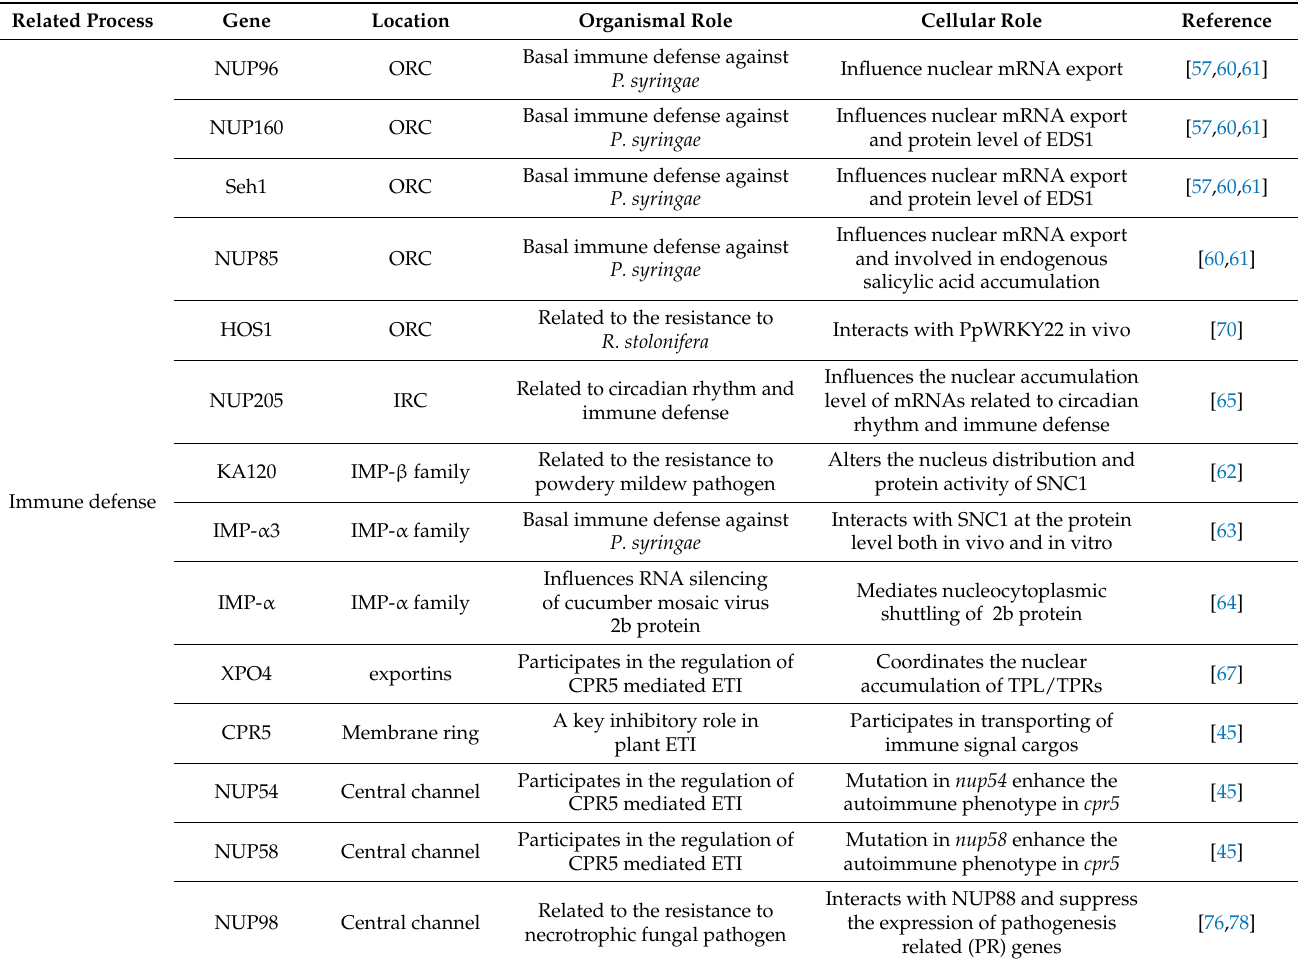
Table 1. Summary physiological processes involved in plant